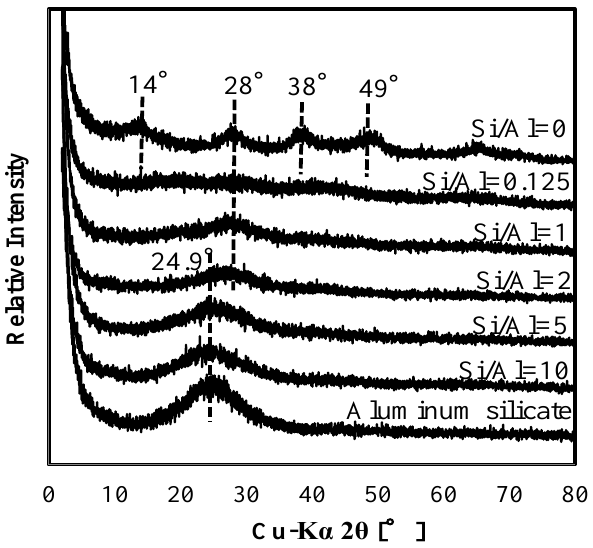
Figure 4. XRD spectra of silicate adsorbed residues obtained at pH 9. The initial aluminum concentration was 1.48 mmol·dm −3